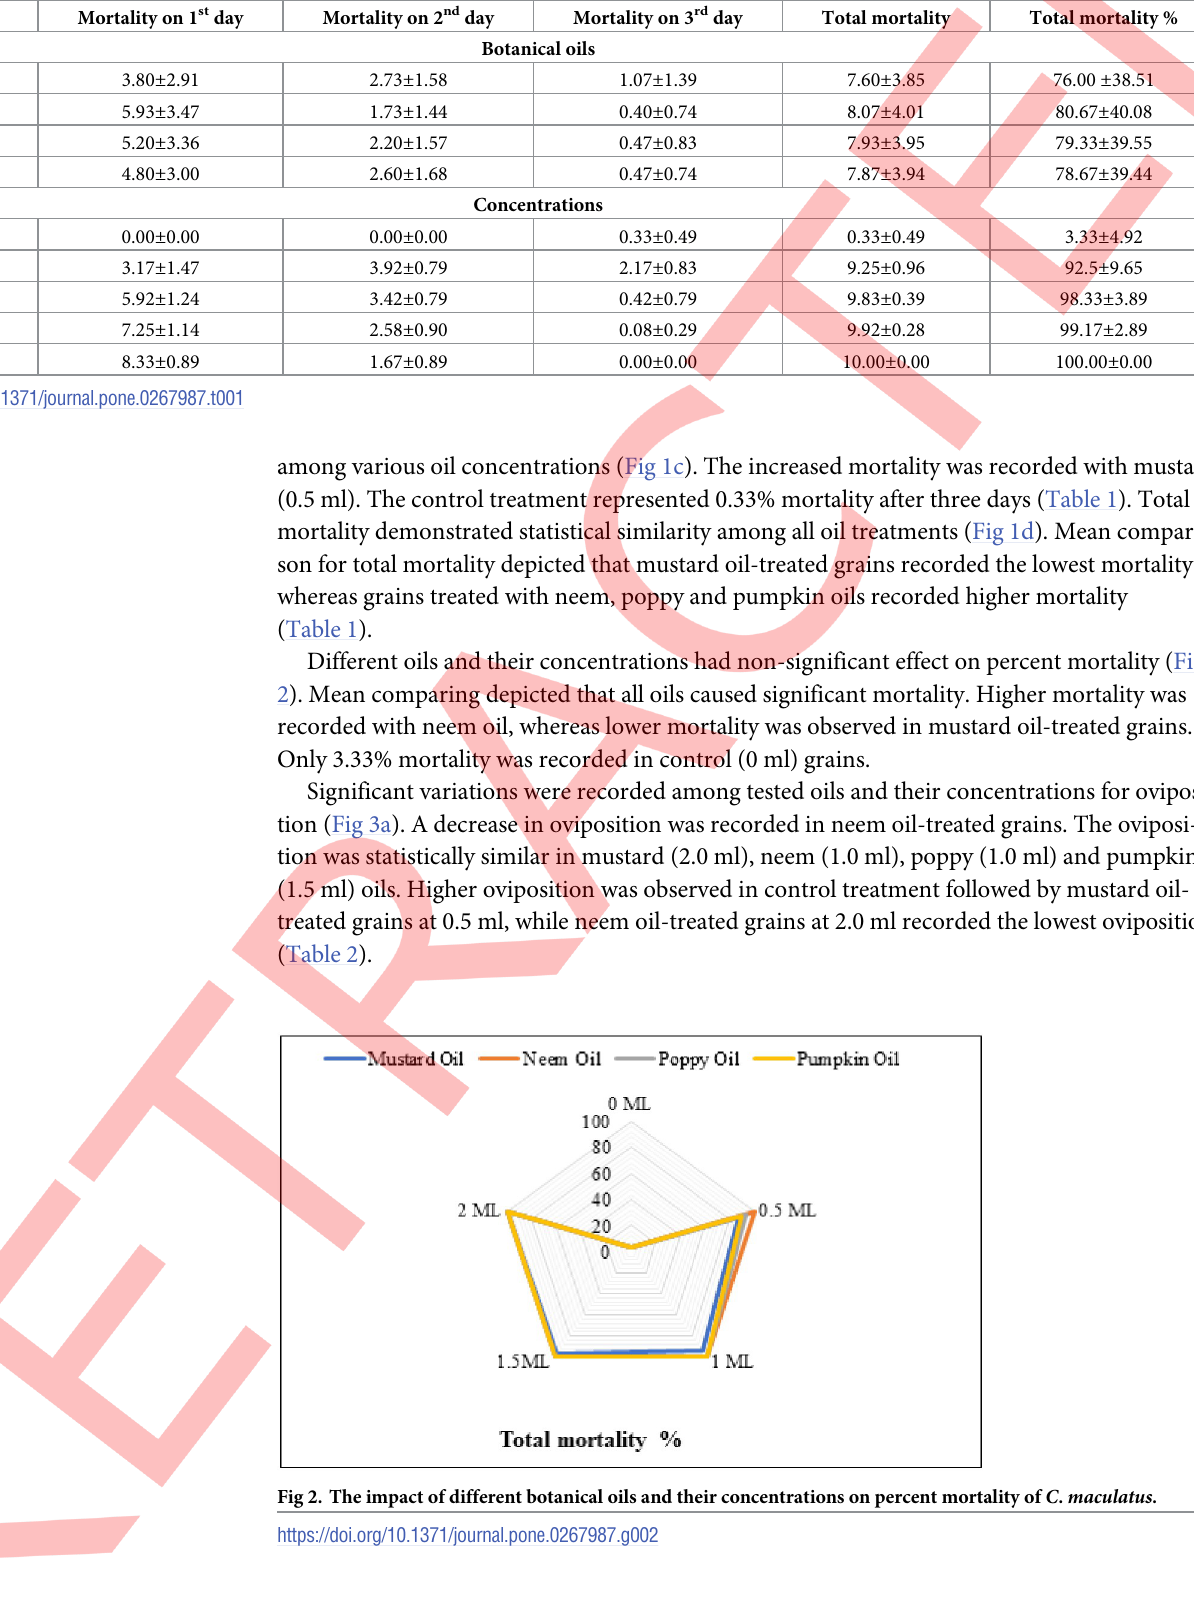
Table 1. The impact of different botanical oils and their concentrations on C . maculatus mortality at different time intervals and total and percentage mortality. Treatments